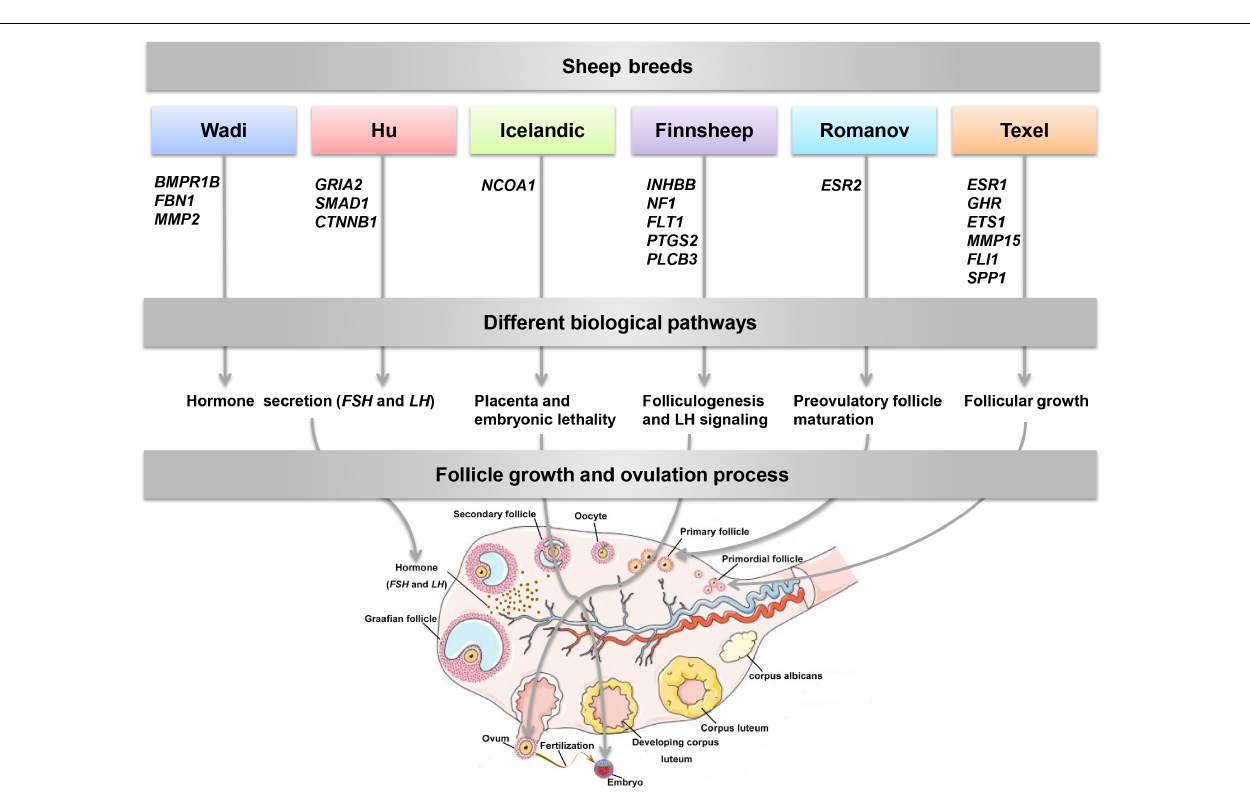
FIGURE 9 | Follicle growth and ovulation process for the role of the candidate genes identified from six sheep breeds in litter